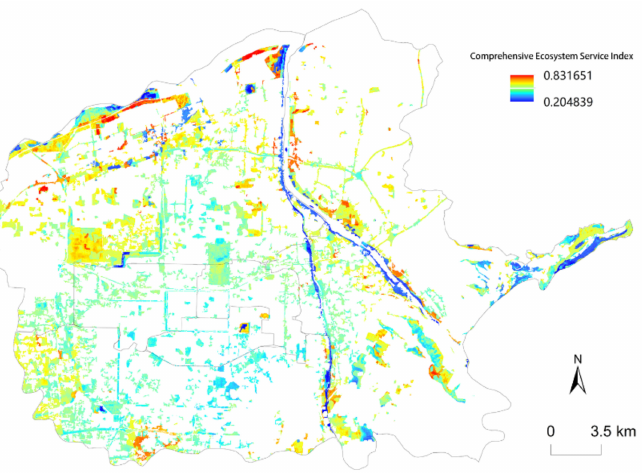
Figure 6. Optimal cluster number